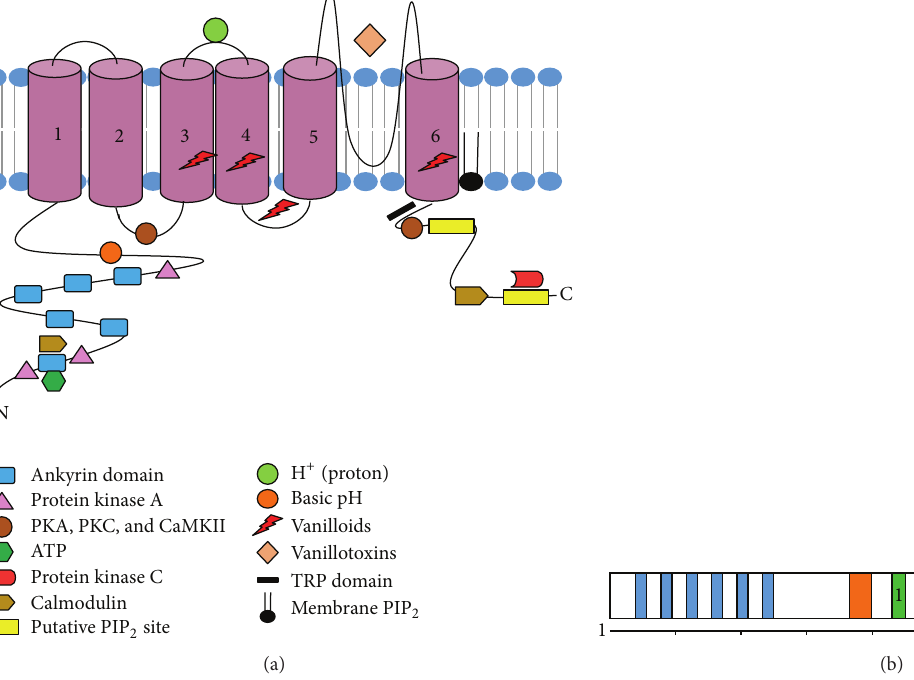
Figure 2: Schematic diagram that illustrates key structural features of TRPV1 control and regulation of channel activity and ion transport. (a) Each TRPV1 subunit is a 95 kDa protein that contains six transmembrane domains, a pore region between the fifth and sixth transmembrane domains, and extended intracellular N- and C-terminal tails. Modified from Bevan et al. [33]. Vanilloid binding site from Yang et al. [32]. (b) ProteindomainsofcanonicalTRPV1receptor(humanTRPV1receptorcontains839aminoacidresidues).BluecolumnsrepresentN-terminal ankyrin repeats, and orange column represents the cytosolic linker domain. The six numbered green columns represent transmembrane domain regions of the receptor, and light yellow column represents the alpha helical domain of the pore-forming region found between transmembrane domains 5 and 6. The red column represents the cytosolic TRP domain, and the two brown columns represent putative C-terminal PIP 2 binding domains. Horizontal line represents the linear sequence of amino acids from the N-terminus to the C-terminus. Modified from Liao et al.